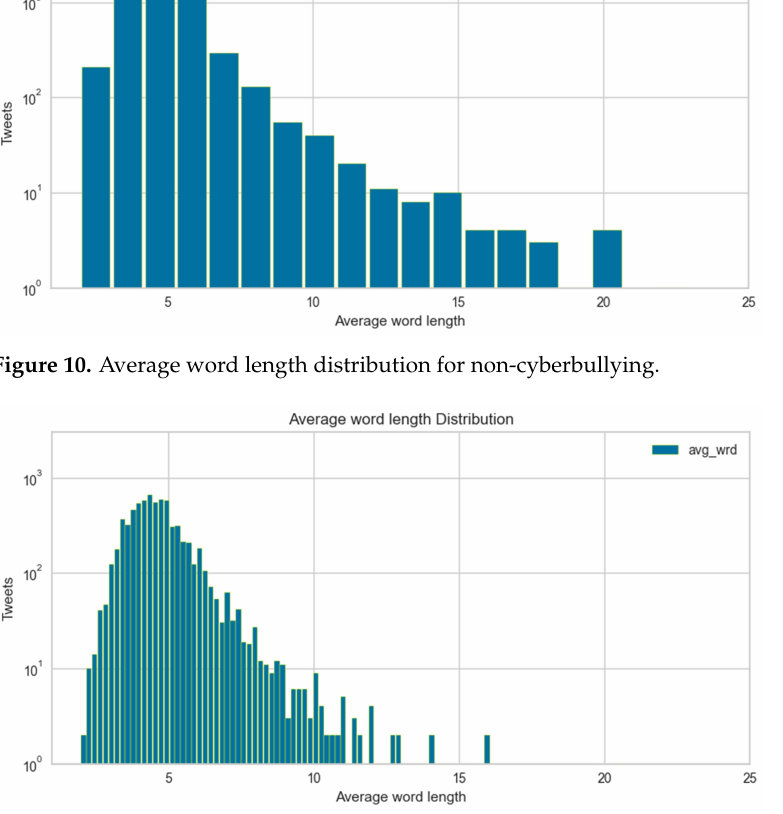
Figure 11. Average word length distribution for